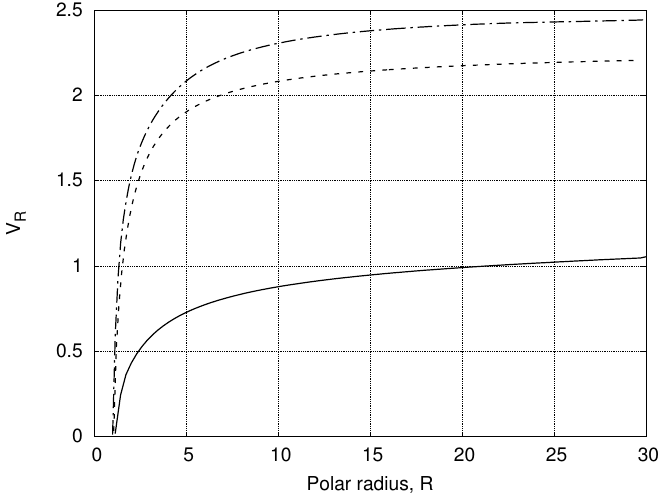
Figure 5. Radial velocity versus polar radius along 3 different radial lines. Solid curve—line along the equator; dashed curve—along the line inclined under 45 ◦ to the equator; dashed–dotted curve—along the axis